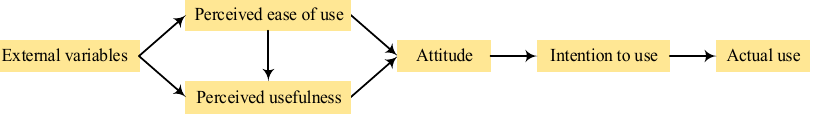
Figure 1. Technology acceptance model.